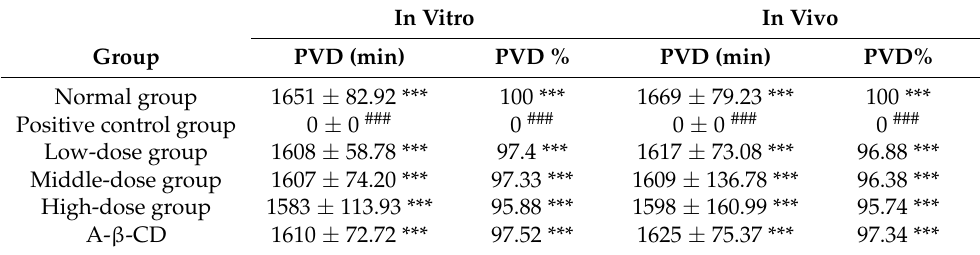
Table 5. Effect of AA on Bufo toad maxillary mucosa.